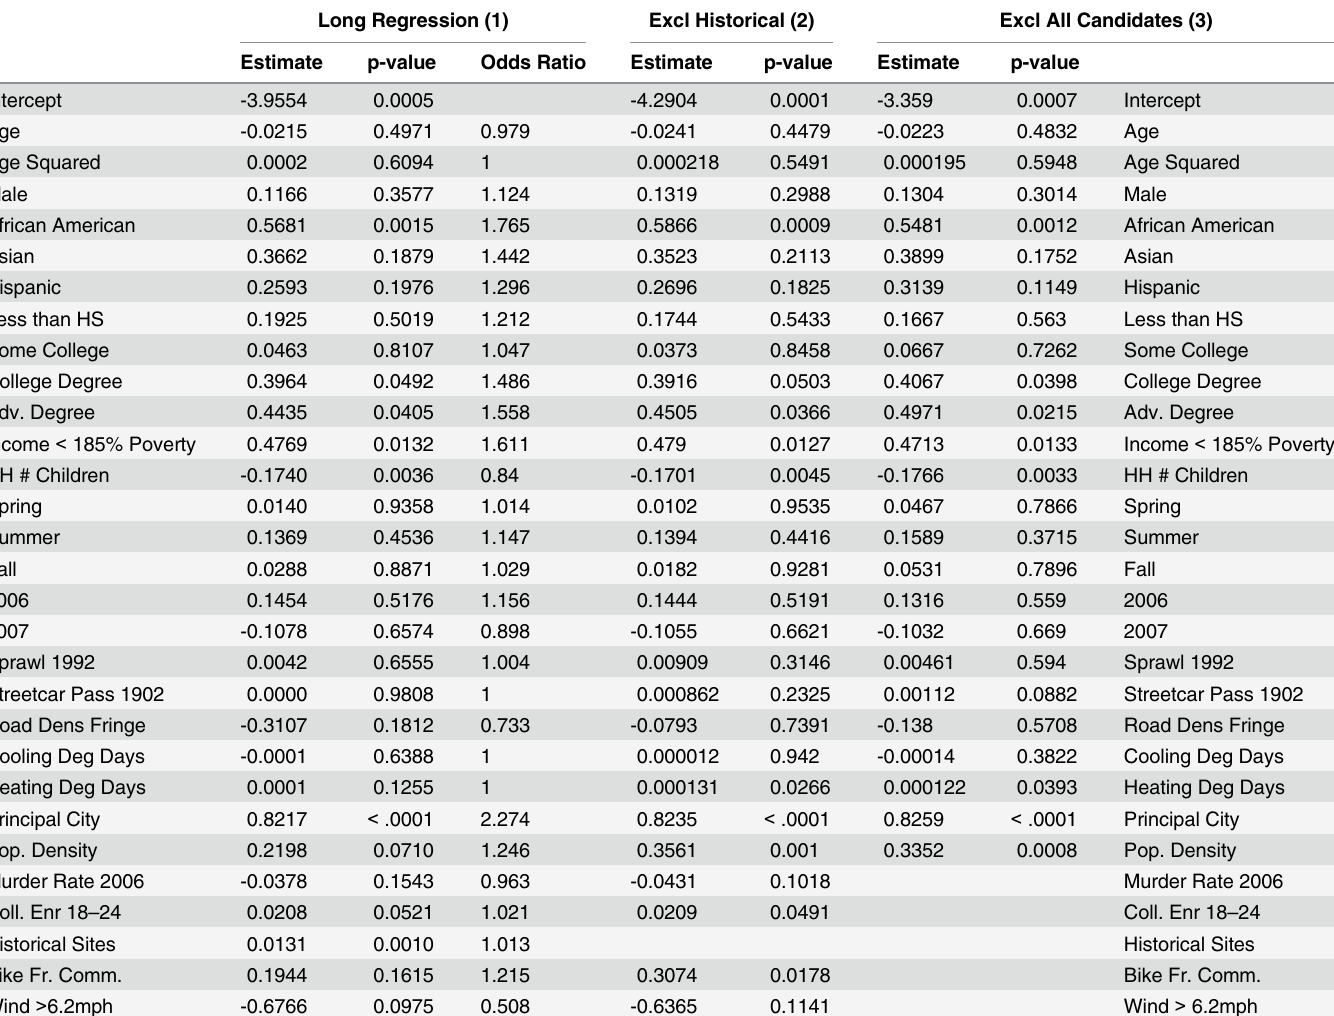
Table 4. Logistical Model of the Probability of Active